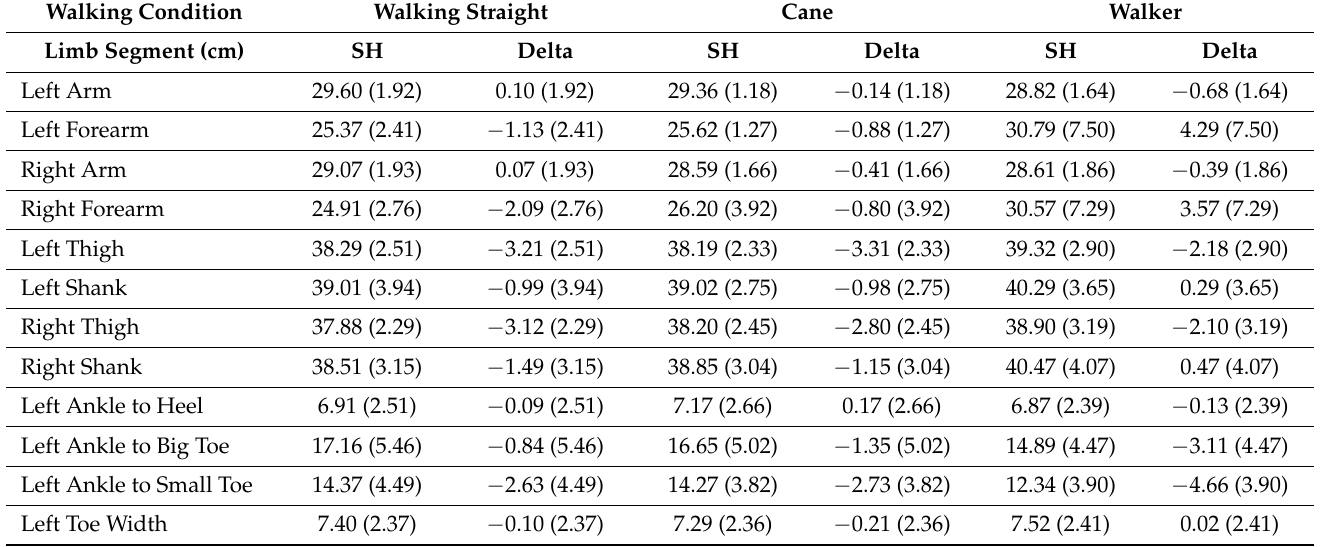
Table 5. Body-segment lengths for participant one: walking straight, cane, and walker test conditions (mean and standard deviation in brackets). Smart Hallway (SH) values were calculated using the 3D reconstructed data, and Delta is the difference between the Smart Hallway and ground-truth segment